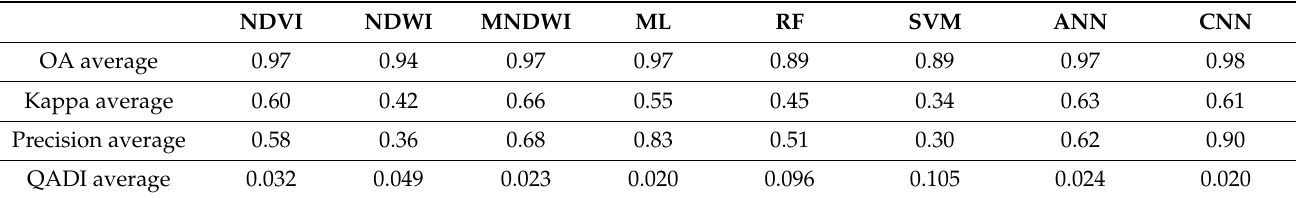
Table 4. Aggregated results of the accuracy